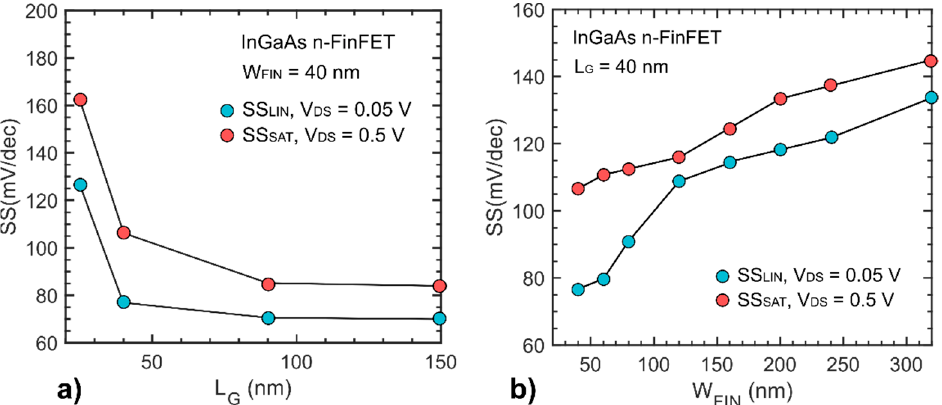
Figure 5. ( a ) Subthreshold slope values versus gate length for devices with W FIN = 40 nm. For LG smaller than 40 nm, short channel effects start dominating the device behavior. ( b ) Average SS versus W FIN for devices with L G = 40 nm. The trend indicates that subthreshold performance benefits from further reducing fin width.